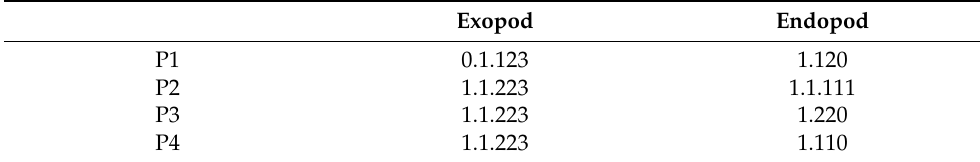
Table 4. Armature formulae of legs